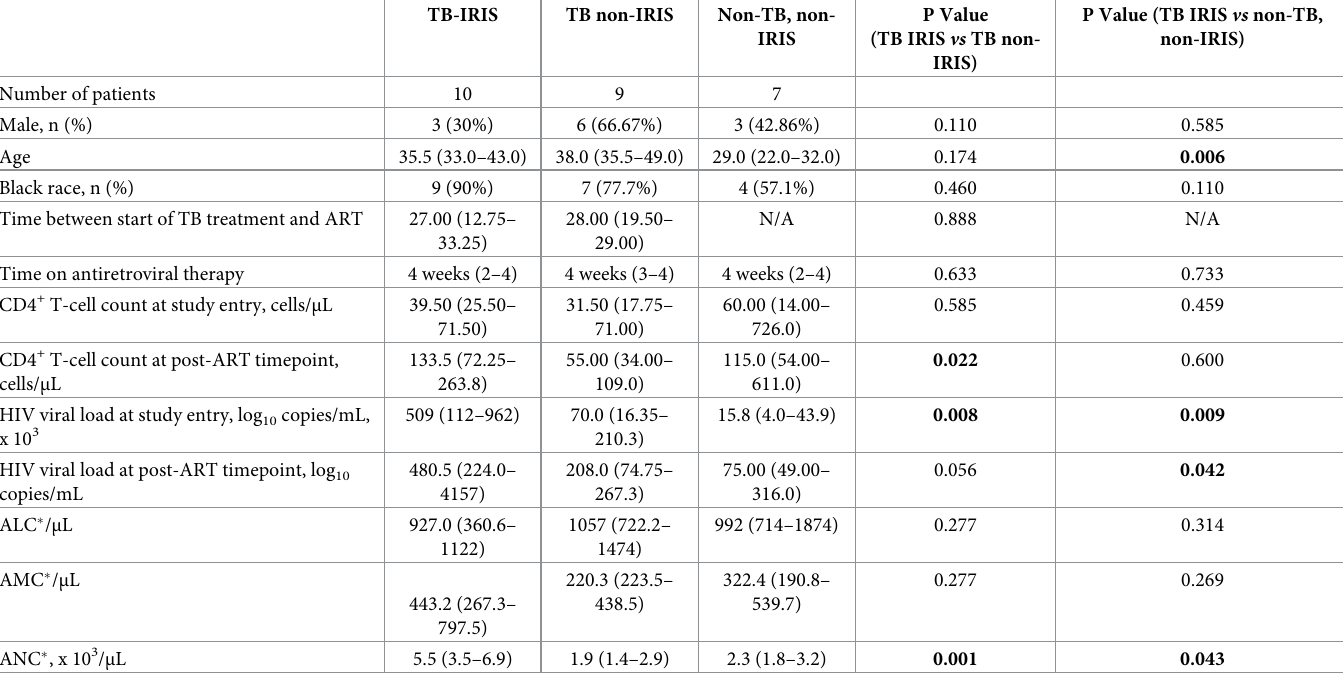
Table 1. Participant characteristics (% or median values with IQR in parenthesis).